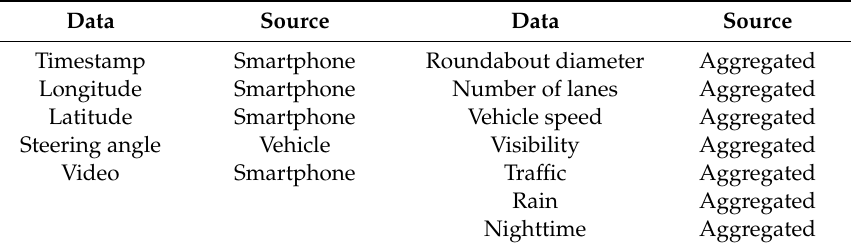
Table 1. List of parameters used for model